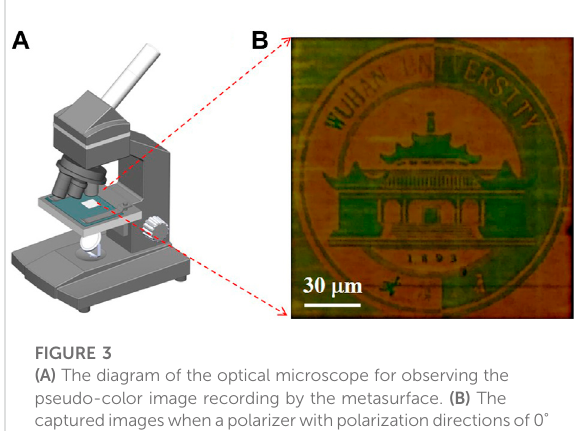
FIGURE 3 (A) The diagram of the optical microscope for observing the pseudo-color image recording by the metasurface. (B) The capturedimageswhenapolarizerwithpolarizationdirectionsof0 ° is inserted before the metasurface. Scale bar: 30 μ